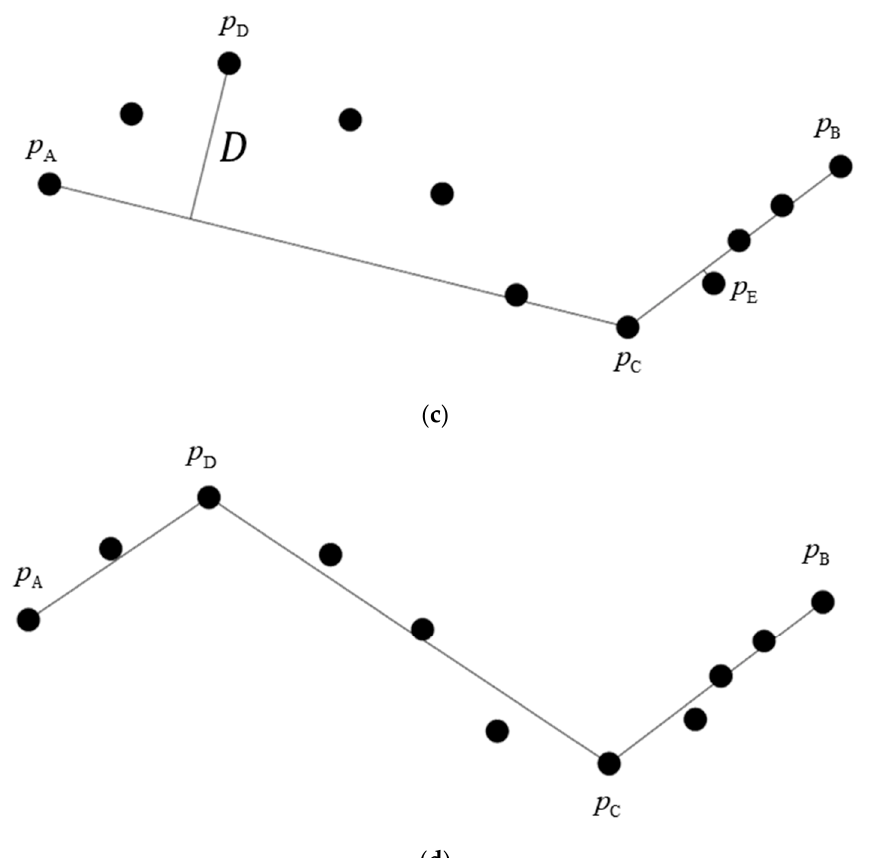
Figure 16. Schematic diagram of Douglas–Peucker algorithm: ( a ) A set of contour points and start point P A and end point P B ; ( b ) Connect start point P A and end point P B . Then, find the furthest point P C and calculate the distance D from the point P C to the line (cid:1842) (cid:3002) (cid:1842) (cid:3003) (cid:3364)(cid:3364)(cid:3364)(cid:3364)(cid:3364)(cid:3364) ; ( c ) If the distance D from the point P C to the line (cid:1842) (cid:3002) (cid:1842) (cid:3003) (cid:3364)(cid:3364)(cid:3364)(cid:3364)(cid:3364)(cid:3364) is bigger than the threshold we set- tled, divide the contour into two parts. Then, calculate the distance D from the point to the line, respectively; ( d ) Else if all of the distance D from the point to the line is smaller than the threshold finish the approximate